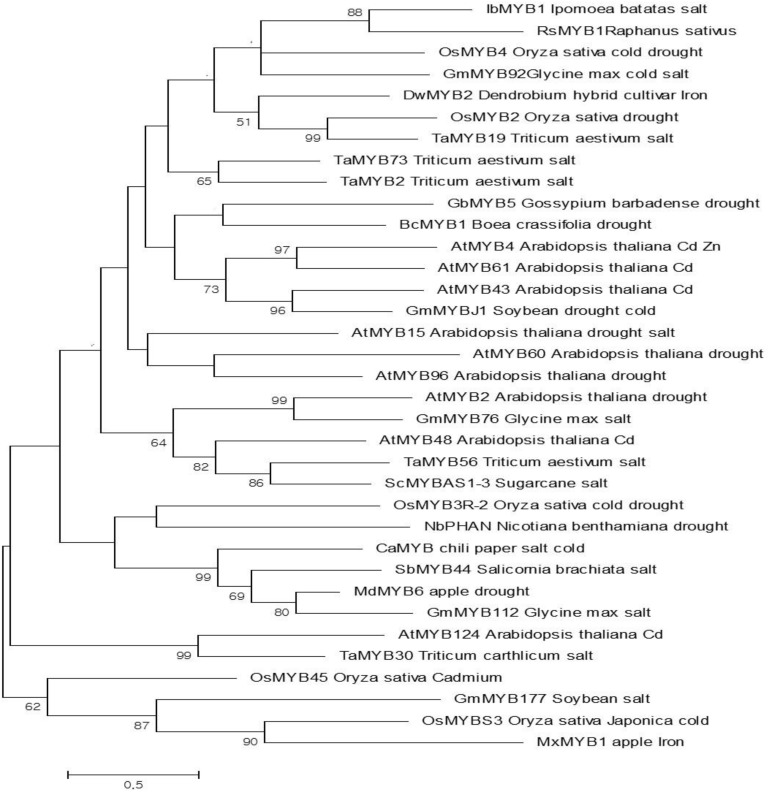
Phylogenetic relationships of the RsMYB1 transcription factor (TF) with other MYB TFs that confer tolerance to various abiotic stresses. The evolutionary history was inferred by using the maximum likelihood method based on the Poisson correction model [1]. The tree with the highest log likelihood (–4439.60) is shown. Initial tree(s) for the heuristic search were obtained automatically by applying neighbor-joining and BioNJ algorithms to a matrix of pairwise distances estimated using a JTT model and then selecting the topology with superior log likelihood value. The tree is drawn to scale, with branch lengths measured in the number of substitutions per site. The analysis involved 35 amino acid sequences. All positions containing gaps and missing data were eliminated. There were 55 positions in the final dataset. Evolutionary analyses were conducted in MEGA7 [2].